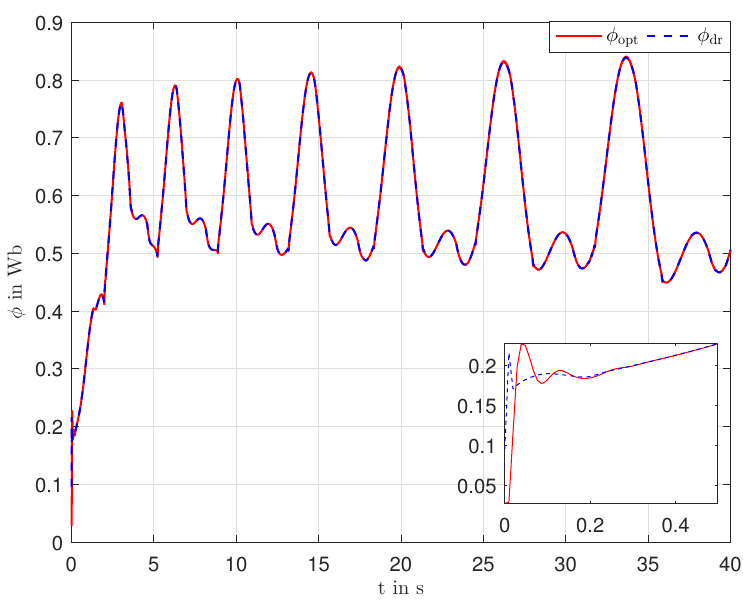
Figure 8. Desired and actual rotor flux of the IM.